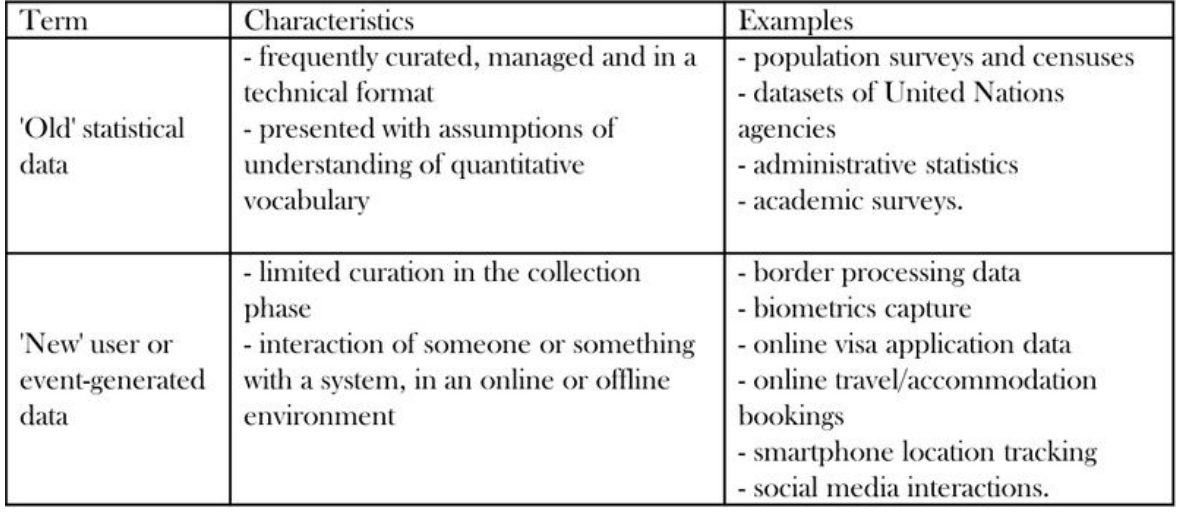
Table 1. Migration data—the ‘old’ and the